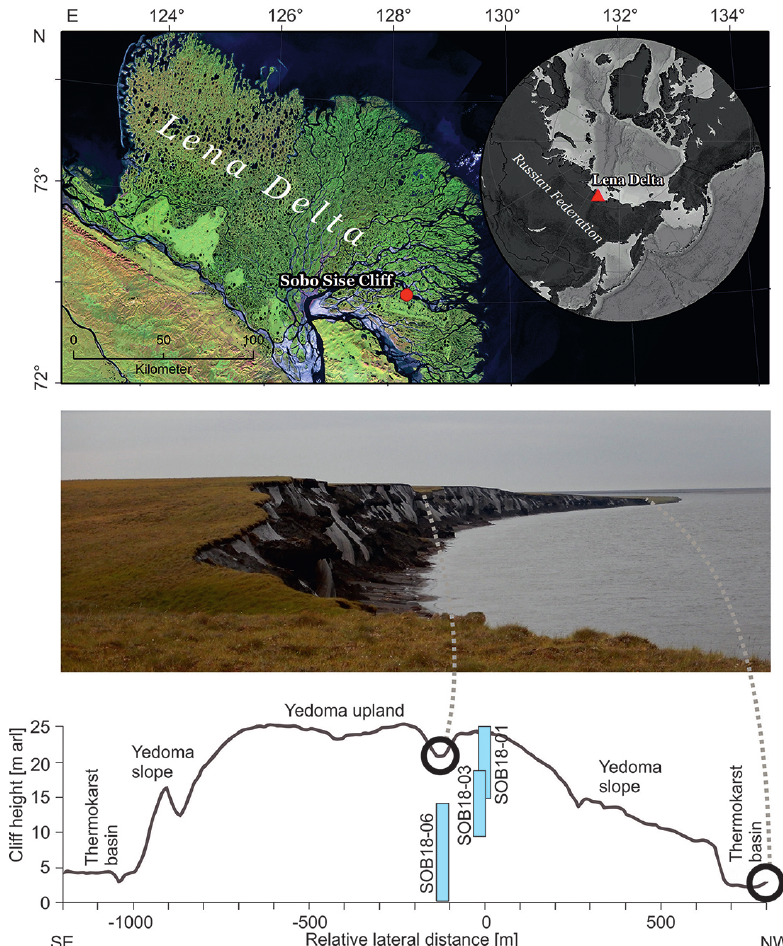
Figure 1. Overview of the Sobo-Sise Yedoma cliff. (a) Location of the Sobo-Sise Yedoma cliff in the Lena Delta in north-eastern Siberia (Landsat 5 mosaic (band combination 5, 4, 3) including scenes from 2009 and 2010; Landsat 5 image courtesy of the US Geological Survey); (b) picture of the Sobo-Sise Yedoma cliff from the east to west; (c) cross-section of the cliff profile (adapted from Wetterich et al., 2020a) indicating the three vertically sampled sections: SOB18-01, SOB18-03 and